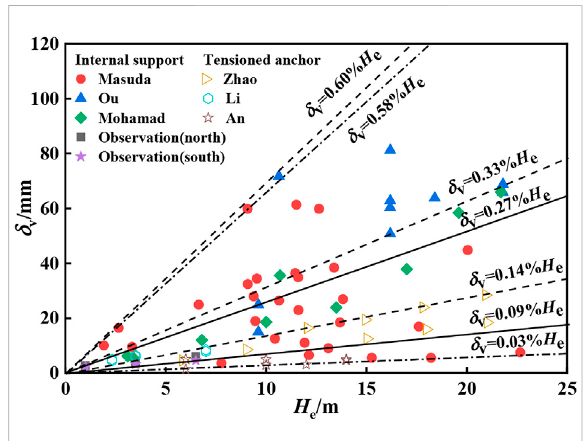
FIGURE 11 Relationship between maximum horizontal displacement of retaining structures and excavation